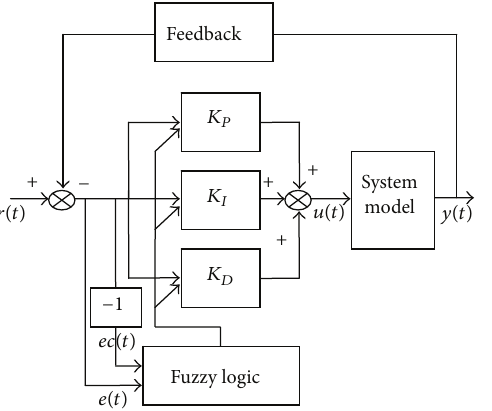
Figure 2: Fuzzy PID control principle.